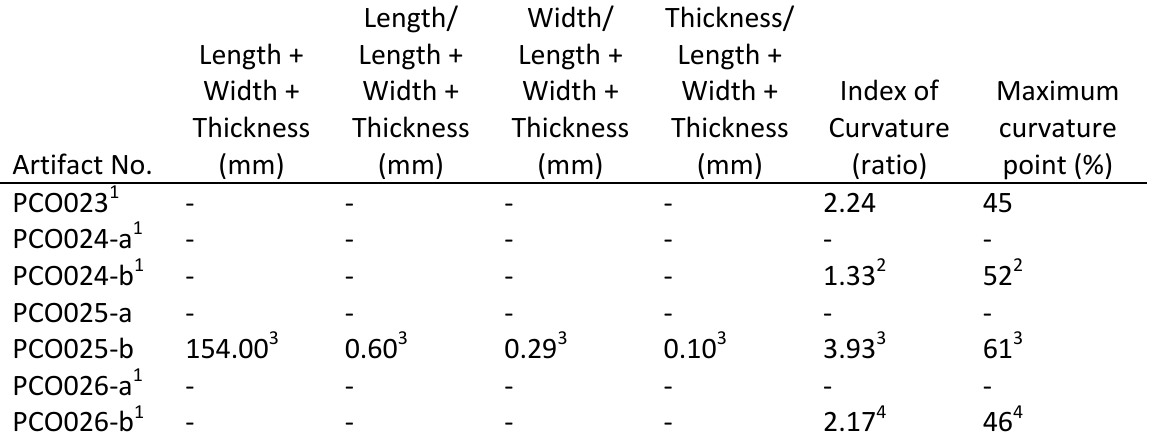
Table 1. Ratios and indices measured in the blades analyzed from Picão